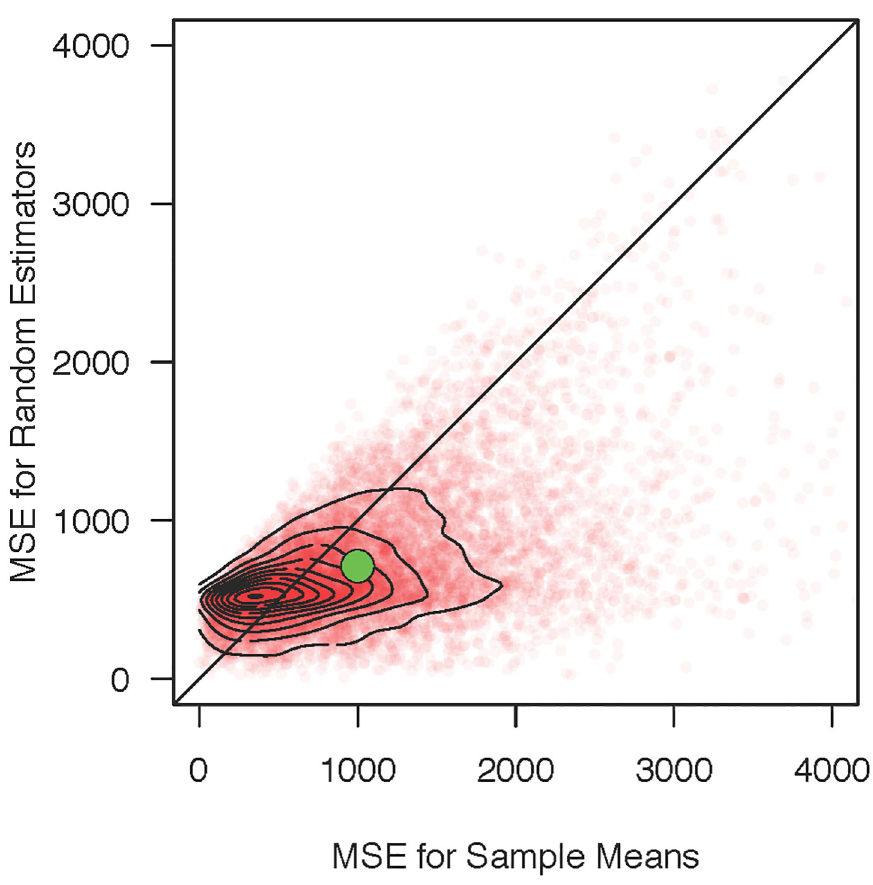
Fig 3. Mean-square error for the sample mean and the random estimator for 10 observations in each of four conditions. Each point shows the result from a simulation repetition, and there are 10,000 such repetitions. Contours are bivariate kernel density estimates. The large point is the mean of MSEs across repetitions. This mean for sample means is 40% larger than the mean for the random estimator, and 63% of samples show larger MSE for the sample